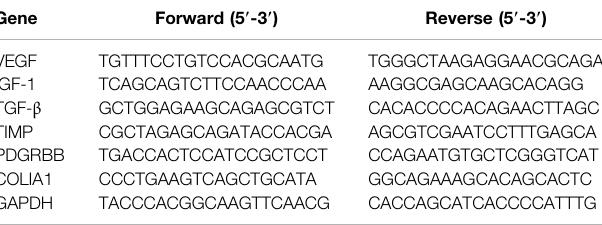
TABLE 1 | Primers of speci fi c genes used in qRT-PCR analyses. Gene Forward (5 9 -3 9